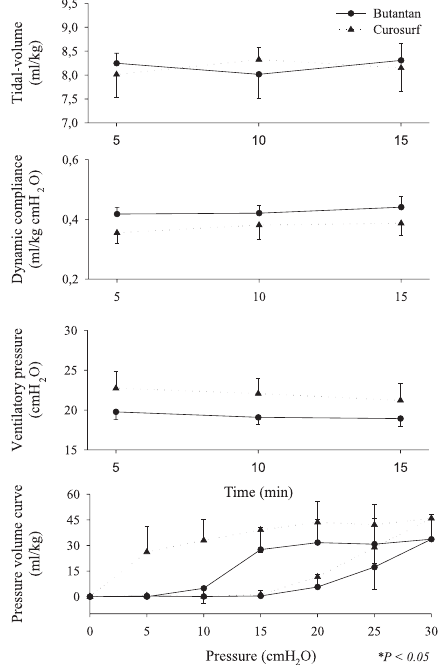
Figure 7 - Time point 5 (180 days after being kept at 20 o C-water bath temperature before being warmed to 37 o C for 5 minutes) data for tidal- volume (V ), dynamic compliance (DC), ventilatory pressure (VP), and t pressure-volume curve (mean ± SD). Data were analyzed by the Student t test (parametric data) or Mann-Whitney test (nonparametric data).